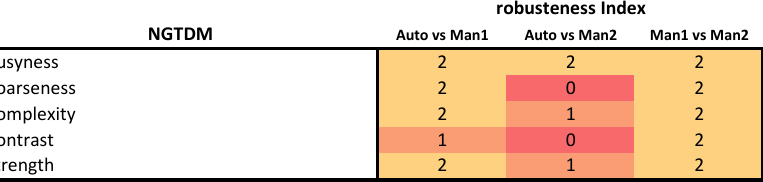
Figure 11. Robustness of the NGTDM radiomic features obtained on DCE-MRI images using auto- mated segmentation against two manual